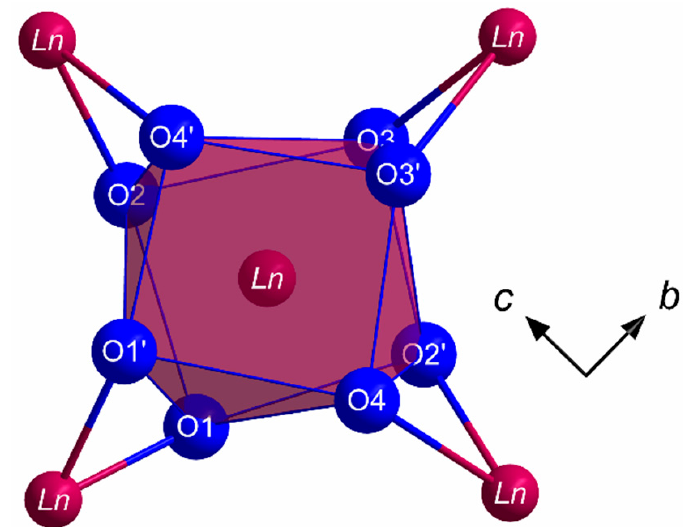
Figure 1. Coordination sphere of the Ln 3+ cations in the crystal structure of the Ln Sb 2 O 4 Br series ( Ln = Eu ‒ Tb) built up by eight oxygen atoms in the shape of a square [ Ln O 8 ] 13 ‒ hemiprism.